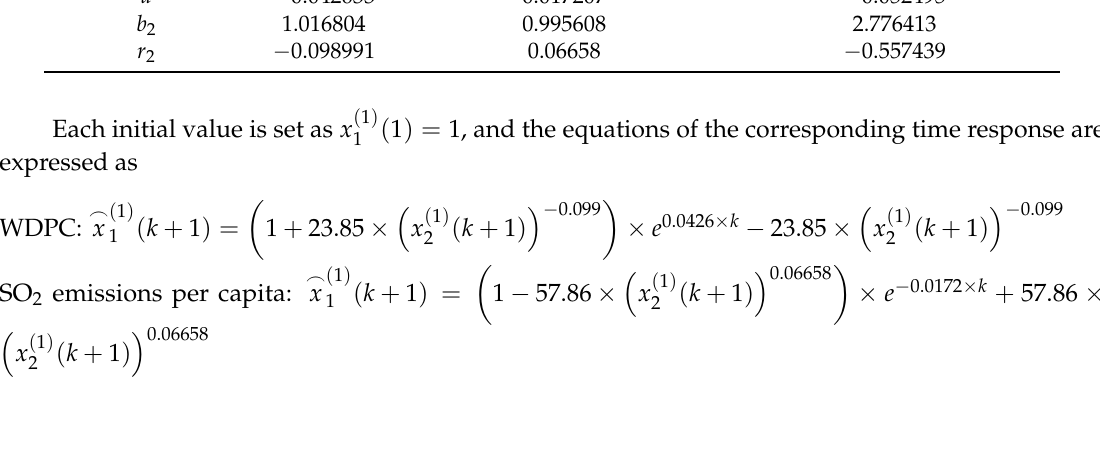
Table 4. The coefficients of NLS-TNGM (1, N ) for three pollutants.